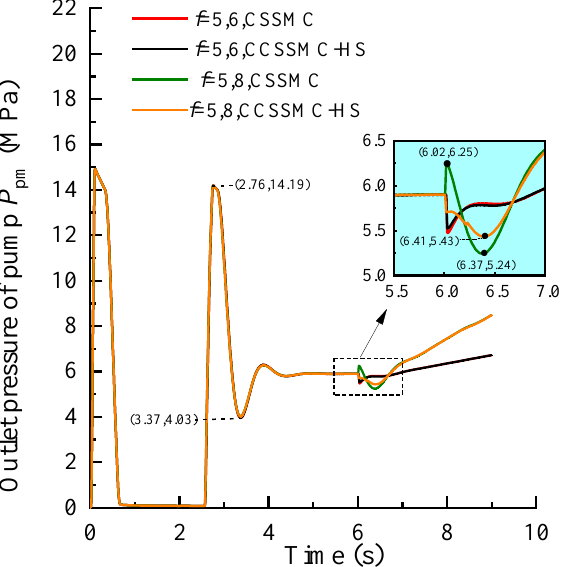
Figure 13. Variation curve of the hydraulic pump outlet pressure based on the CSSMC and CSSMC- HS.